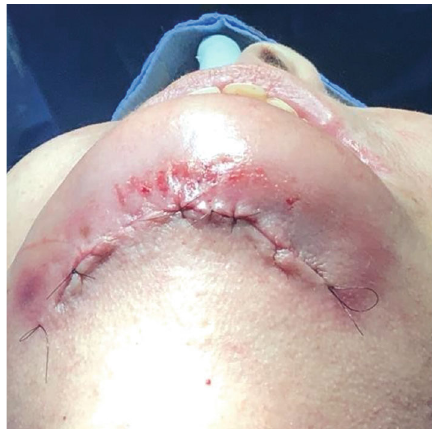
Figure 5: Tissue repositioning with a synthesis operation on the suprahyoid muscles.